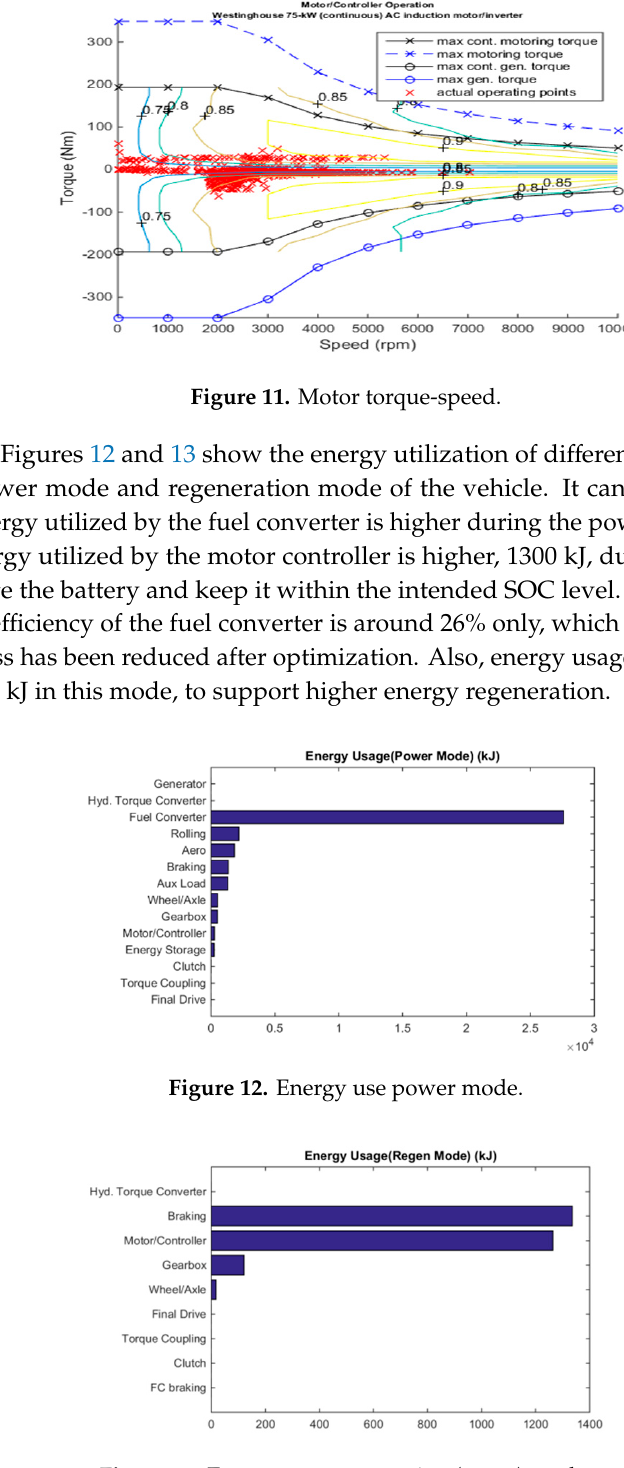
Figure 13. Energy use regeneration (regen)